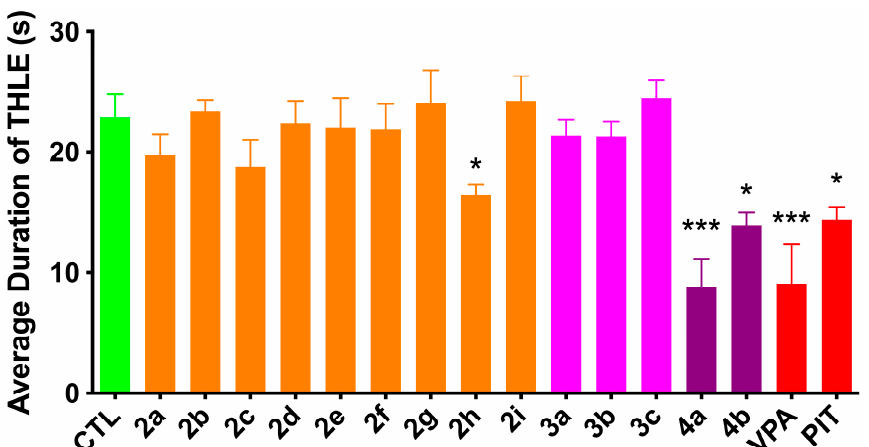
Figure 2. The protection of H 3 R antagonists 2a-2i , 3a-3c , 4a-4b (10 mg/kg, i.p.), PIT (10 mg/kg, i.p.), and the antiepileptic drug VPA (300 mg/kg, i.p.) in the maximal electroshock seizure model. The definition of protection was the reduction or vanishing of the tonic hind limb extension (THLE). Data are shown as mean ± SEM in the figure, which are derived from seven animals in each group. * p < 0.05, *** p < 0.001 when compared to the control group (CTL).